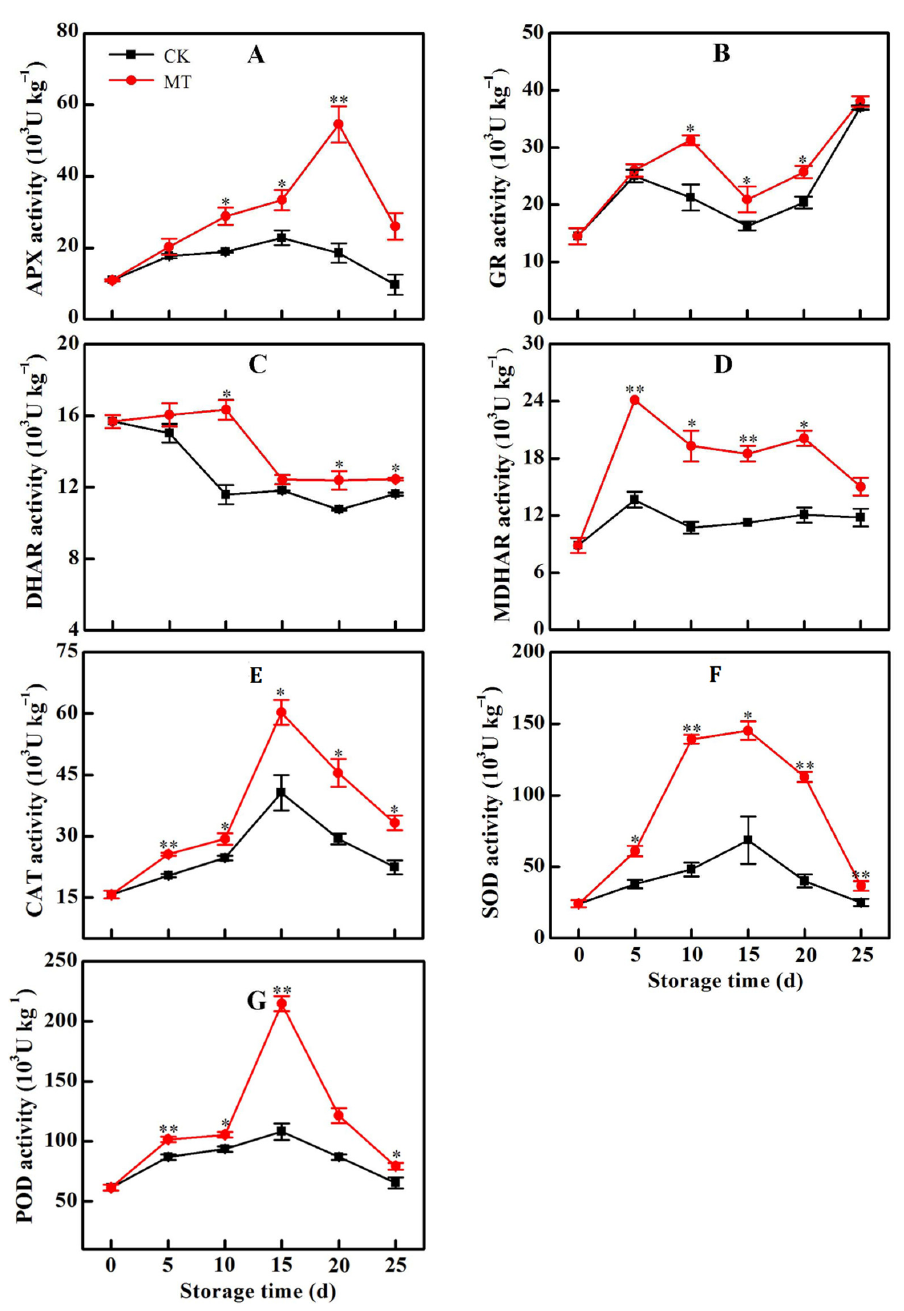
Figure 5. Change in the activities of APX ( A ), GR ( B ), DHAR ( C ), MDHAR ( D ), POD ( E ), CAT ( F ) and SOD ( G ) in horn pepper fruit during cold storage after treatment with water (CK) or melatonin (MT). Asterisks * and ** indicate the significant differences ( p < 0.05 or p < 0.01, respectively) between